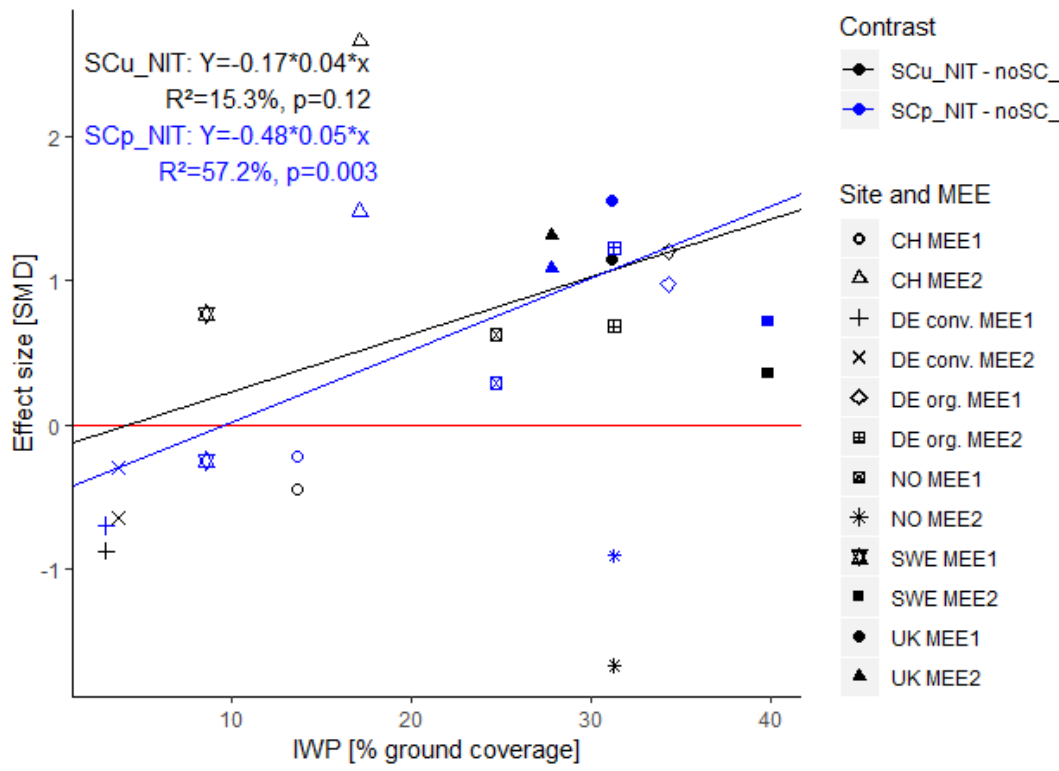
Figure 5. The relation between the average of weed coverage over all treatments and the effect of the alternative system (based on under-sown subsidiary crops (SCu) in black and subsidiary crops sown post-harvest (SCp) in blue) on weed coverage compared to the conventional system. The values for the effect sizes are given in standardized mean difference (SMD). A negative SMD represents a lesser weed coverage associated with the alternative system compared to conventional system, and vice versa. Note that NO MEE2 (*) is treated as an outlier.